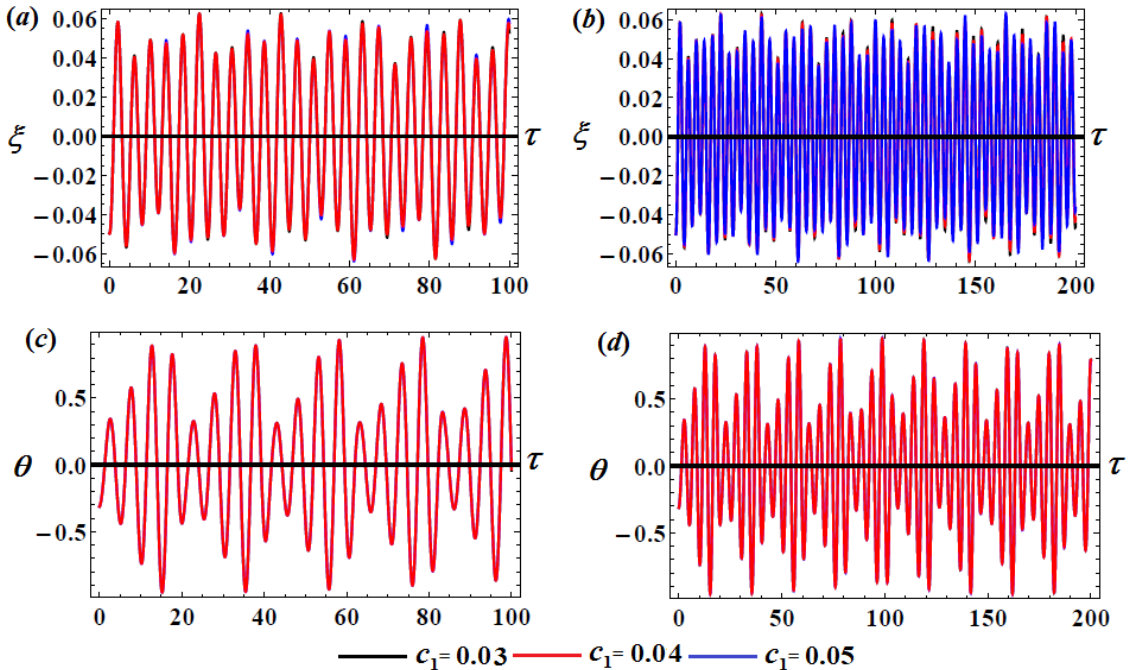
Figure 3. Time history portraits of ξ and θ when ω 2 (= 2.1,2.2,2.3 ) s − 1 , c 1 = 0.02, and c 2 = 0.03 m − 2 : ( a , c ) during the time interval [0,100] s and ( b , d ) during the time interval [0,200] s .